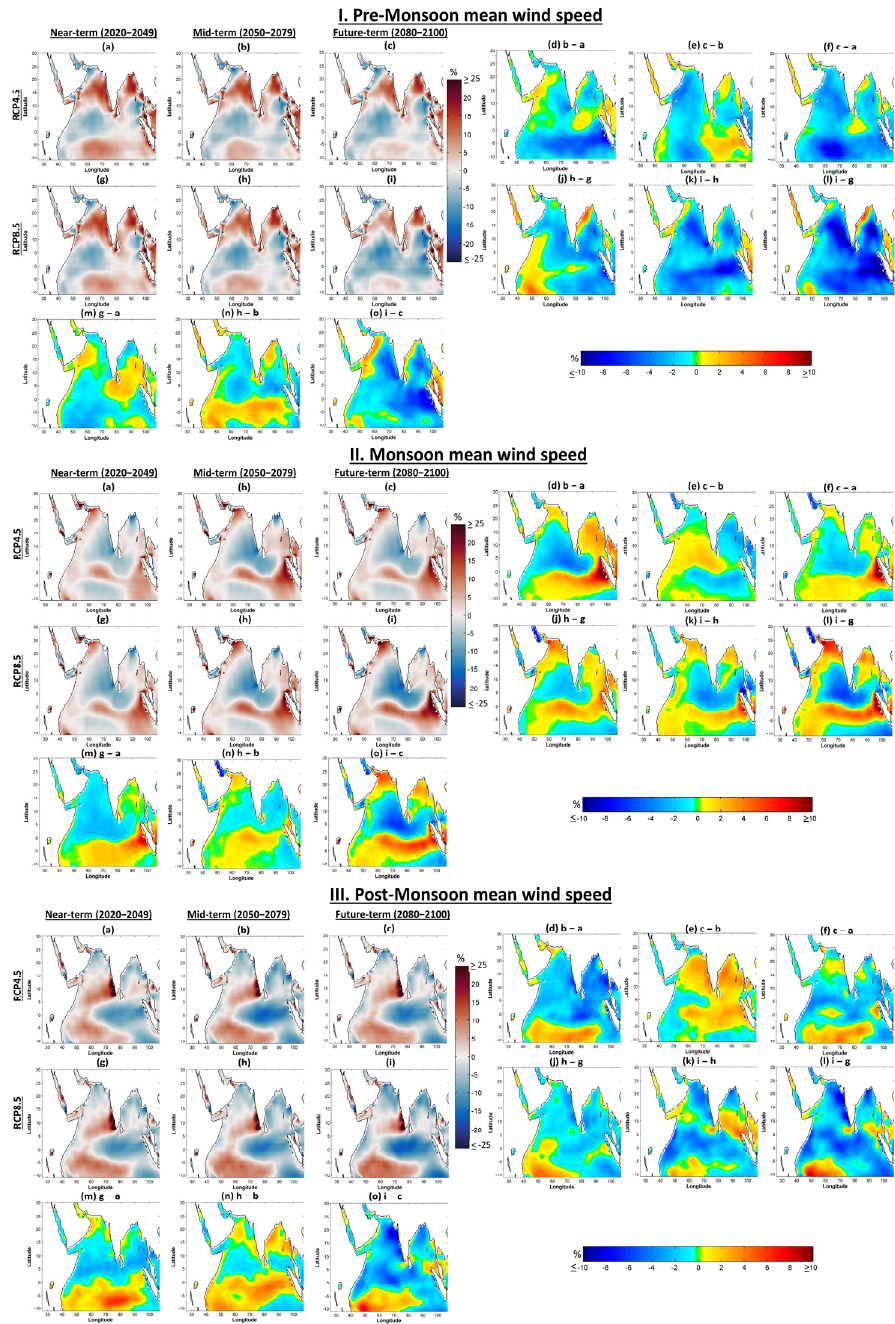
Figure 12. As in Figure 11, but for ( I ) pre ‐ monsoon (February − May), ( II ) monsoon (June − Septem ‐ ber), and ( III ) post ‐ monsoon (October −